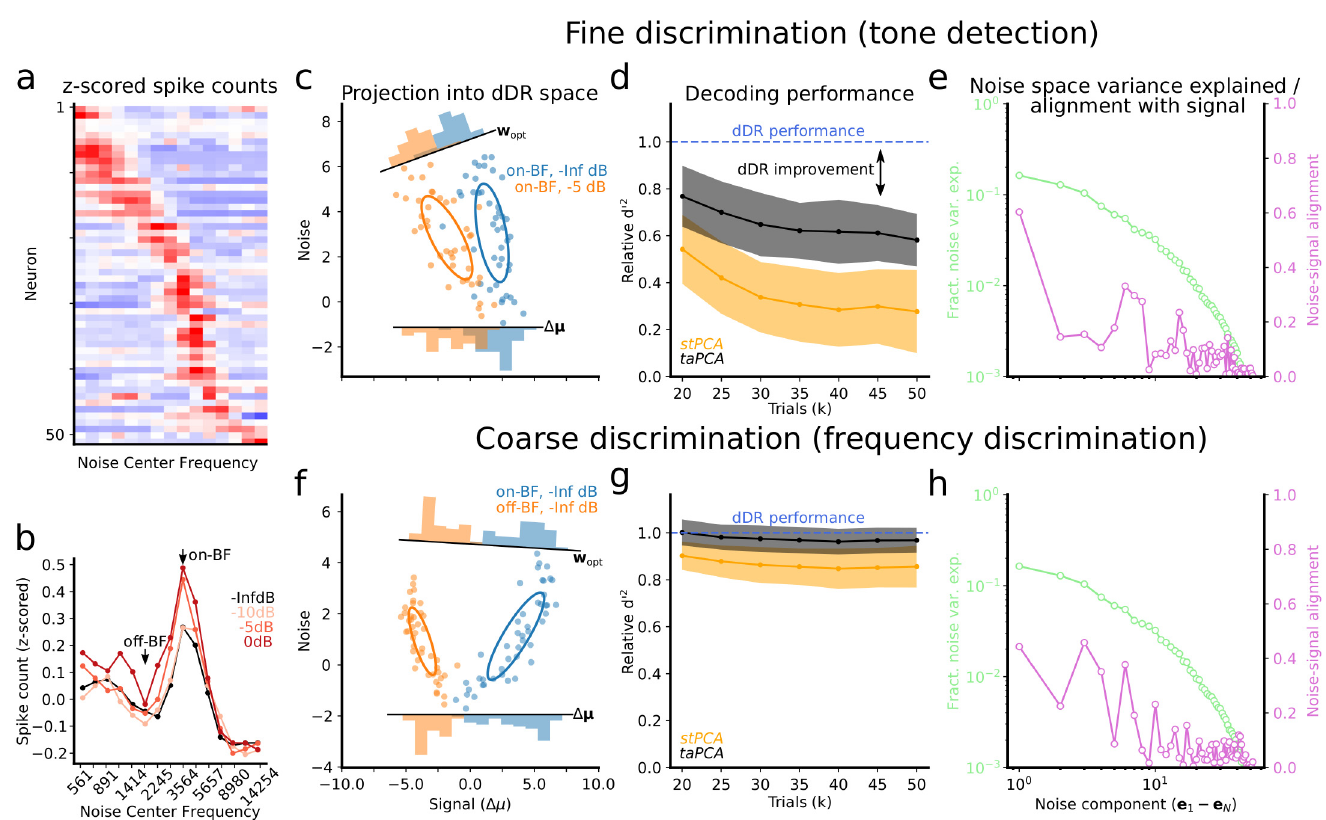
Fig 6. dDR outperforms PCA for fine sensory discrimination. a . Heatmap shows mean z -scored spike counts of N = 52 simultaneously recorded units for 15 different narrowband noise bursts (0.3 octave bandwidth tiling 5 octaves, x -axis). Each row shows tuning for one unit, with red indicating higher firing rate response. x-axis (Noise Center Frequency of the sound stimulus) is shared with panel b. b . Population tuning curve for noise alone (black, data from panel a) and noise plus − 10, − 5, and 0 dB tones (light to dark red), computed by averaging tuning curves across neurons. c-e . Decoding analysis for tone-in-noise detection. c . Scatter plot compares single trial responses to noise alone at best frequency (on-BF, blue) vs. noise + − 5dB tone (orange), projected into dDR space. Ellipses show standard deviation across trials, marginal histograms show projection of data onto optimal decoding axis ( w opt ) or onto Δ μ (equivalent to performing trial-averaged PCA ). d . Estimate of relative d 0 2 as a function of sample size (number of trials, k ) using each dimensionality reduction method. For each data point, relative d 0 2 was measured between taPCA vs. dDR and stPCA vs. dDR . This metric was averaged over 200 bootstrap samples of k trials. Shading indicates standard error. See Methods for details. e . Fraction variance explained by each noise component (green) computed by performing PCA on mean-centered single trial data. The alignment of each noise component with the signal axis is shown in purple. f-h Same as panels (c)-(e), for noise alone on-BF vs. noise alone off-BF (see panel